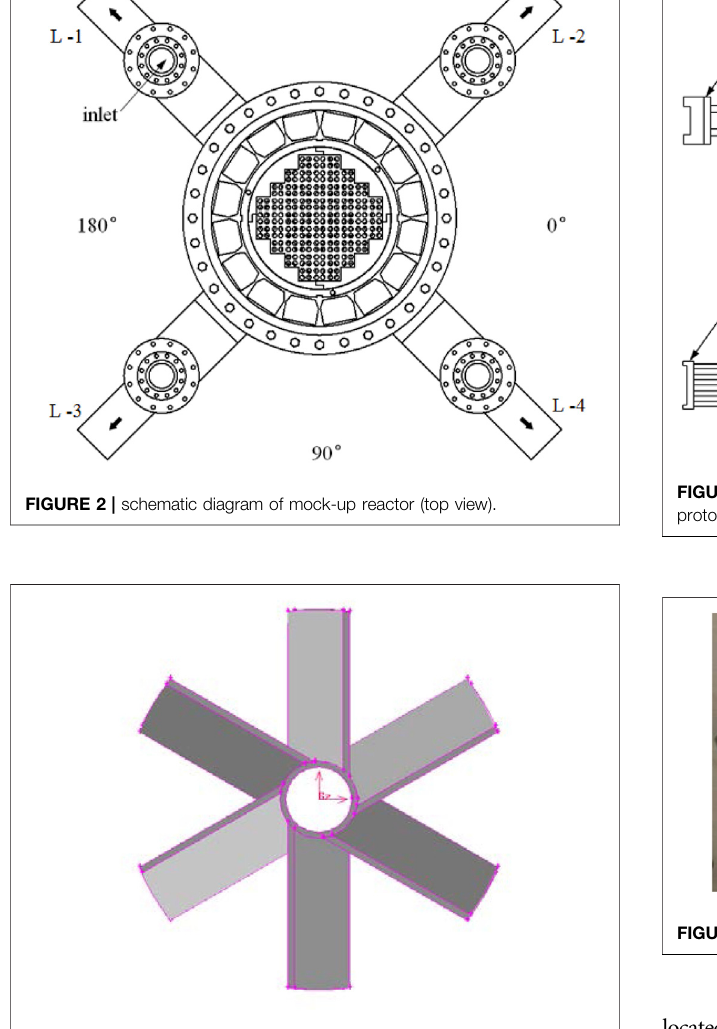
FIGURE 3 | schematic diagram of swirl generator.